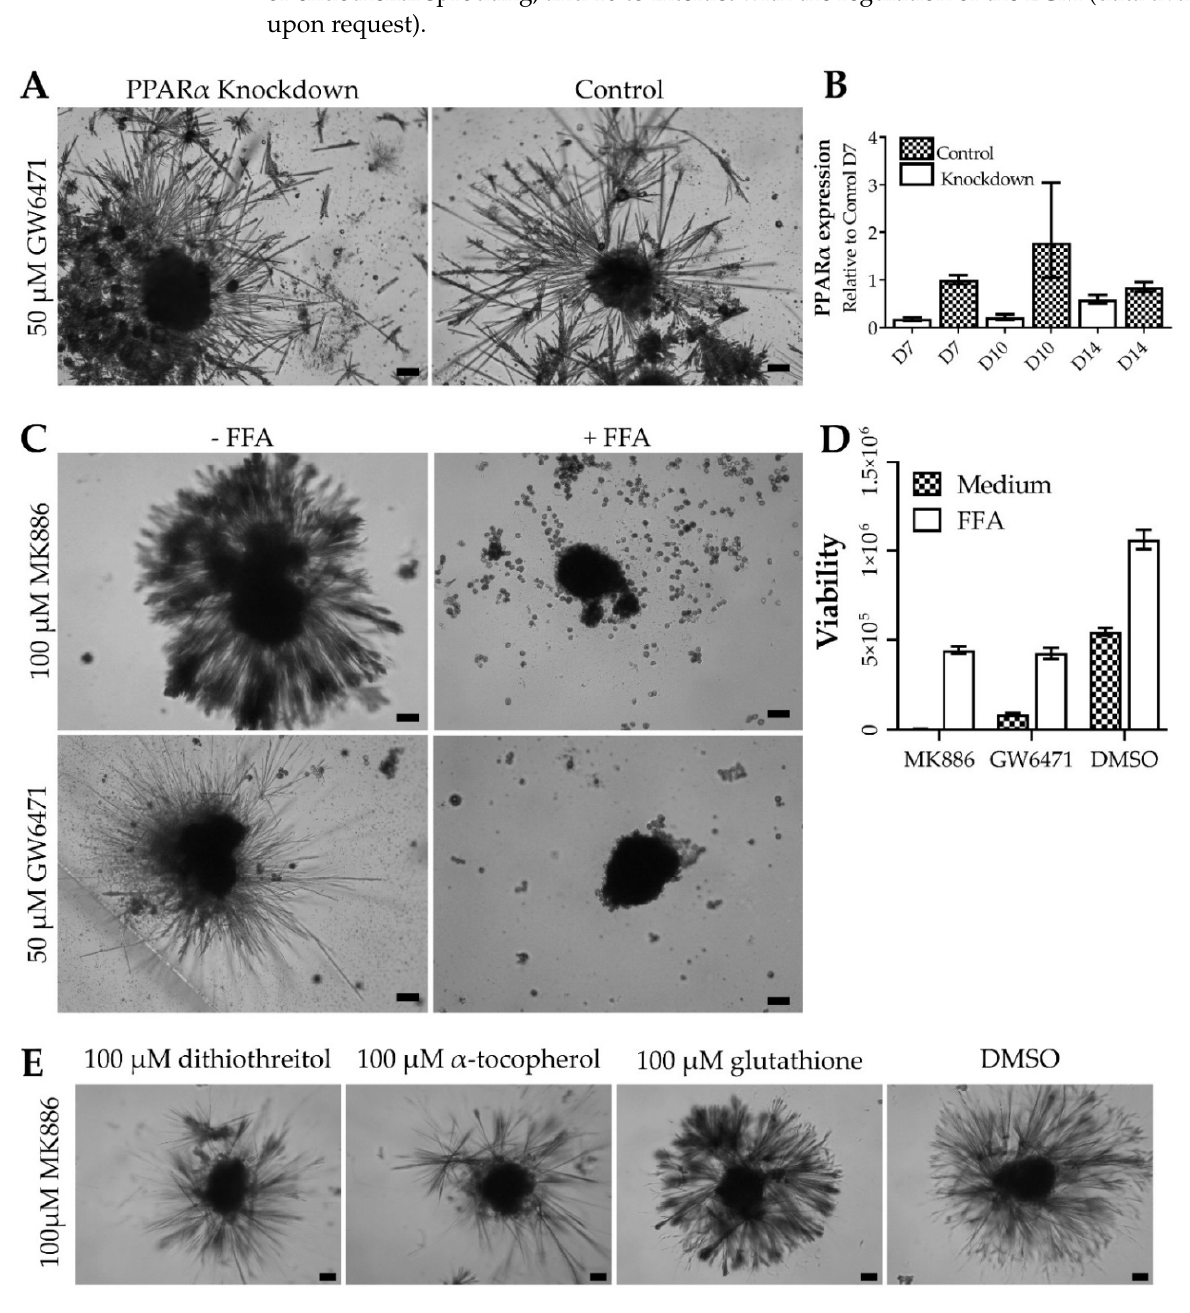
Figure 3. Mechanisms of thorn formation. ( A ) Brightfield micrographs showing the effects of siRNA- mediated PPAR α knockdown thorn formation in donor 1 PHH spheroids. Spheroids were treated with 50 µ M GW6471 for 72 h. ( B ) PPAR α knockdown validated by qPCR of PPAR α . ( C ) Brightfield micrographs of thorn formation in donor 1 PHH spheroids after treatment with 50 µ M GW6471 or 100 µ M MK886 with or without FFA supplementation for 72 h. ( D ) Viability of donor 1 spheroids treated, as described in panel C. ( E ). Brightfield micrographs of donor 1 PHH spheroids treated with 100 µ M MK886 with either 100 µ M α -tocopherol, 100 µ M dithiothreitol, 100 µ M glutathione, or 0.1% ( v / v ) DMSO. Scale bars are 10 µ